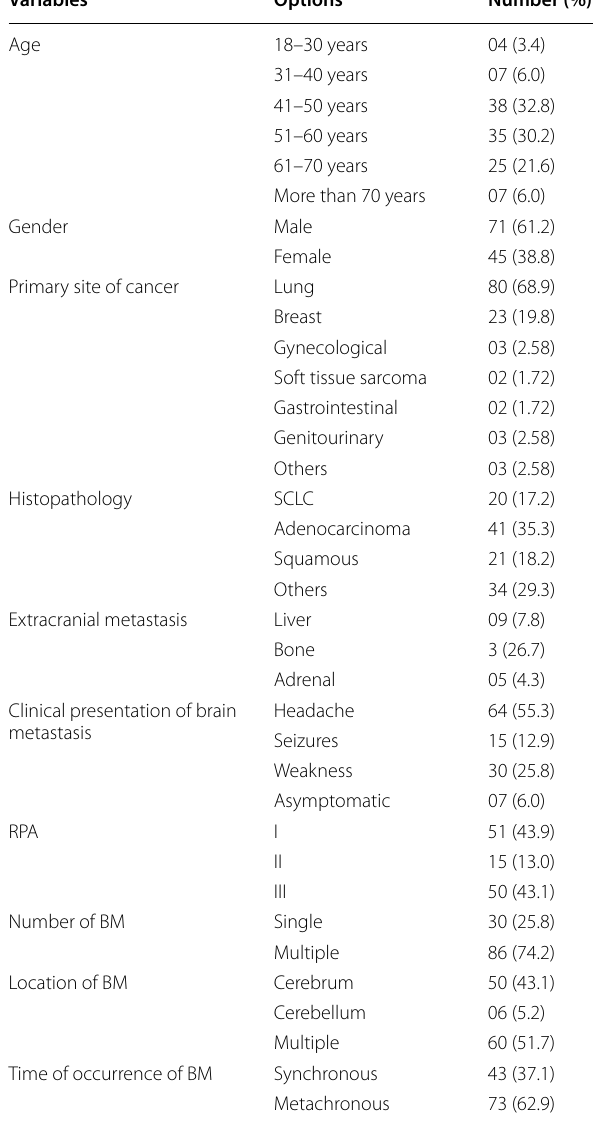
116) Table 2 Treatment and outcome of BM =